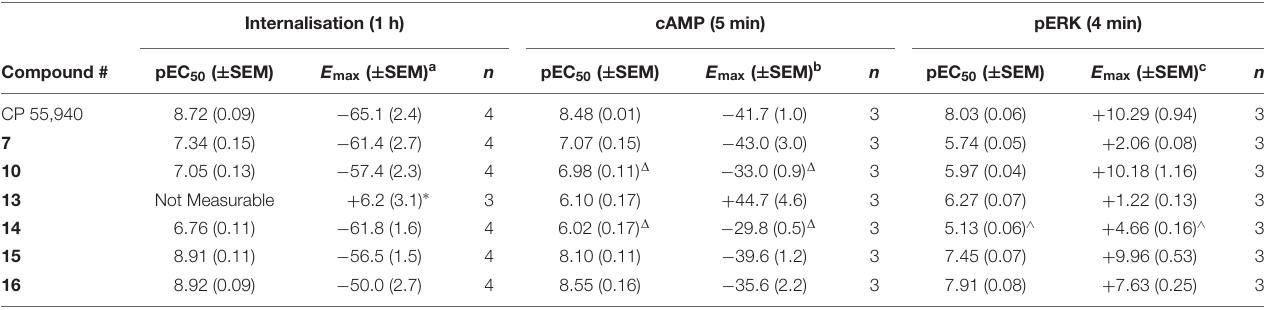
TABLE 2 | Summary data for hCB 2 functional assays carried out on CP 55,940 and 2,4,6-trisubstituted